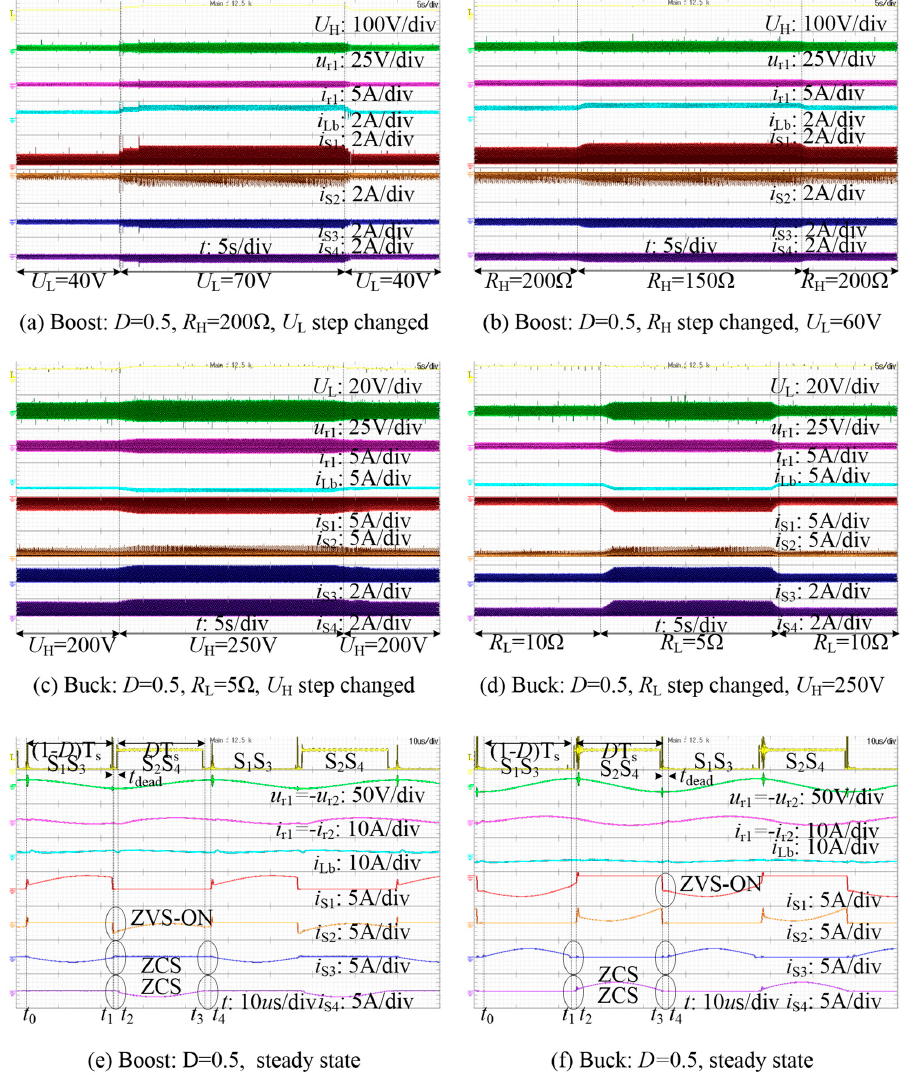
Figure 7. Experimental verification of the IHBCLLC TL-BDC.